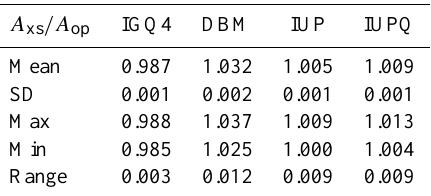
Fig. 5. Ratio of the different cross section ( A i, xs ) to the operative cross-section ( A i, op ) for each Brewer instrument against the differ- ence in wavelength ( λ 6 − λ 6 ( nominal ) ) to the nominal value for slit 6. Table 4. Statistics of the ratio of the absorption coefficient ( A xs /A op ) to the operative cross section (Bop) to that calculated with cross sections of this study: B&P from the IGACO web page (IGQ4); Daumont, Brion and Malicet (DBM); the University of Bremen (IUP) and the UIP at − 45 ◦ C from the quadratic fit of IUP set (IUPQ).